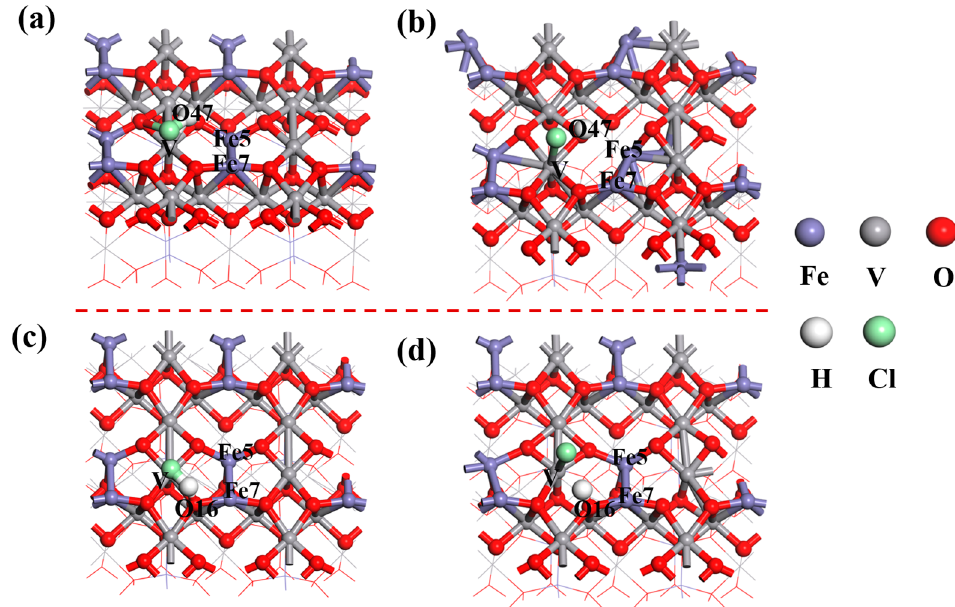
Figure 9. HCl adsorption on FeV 2 O 4 : ( a ) HCl adsorption on V-O47 site before optimization. ( b ) HCl adsorption on V-O47 site after optimization. ( c ) HCl adsorption on V-O16 site before optimization. ( d ) HCl adsorption on V-O16 site after optimization. Table 4. HCl adsorption energy on FeV 2 O 4.